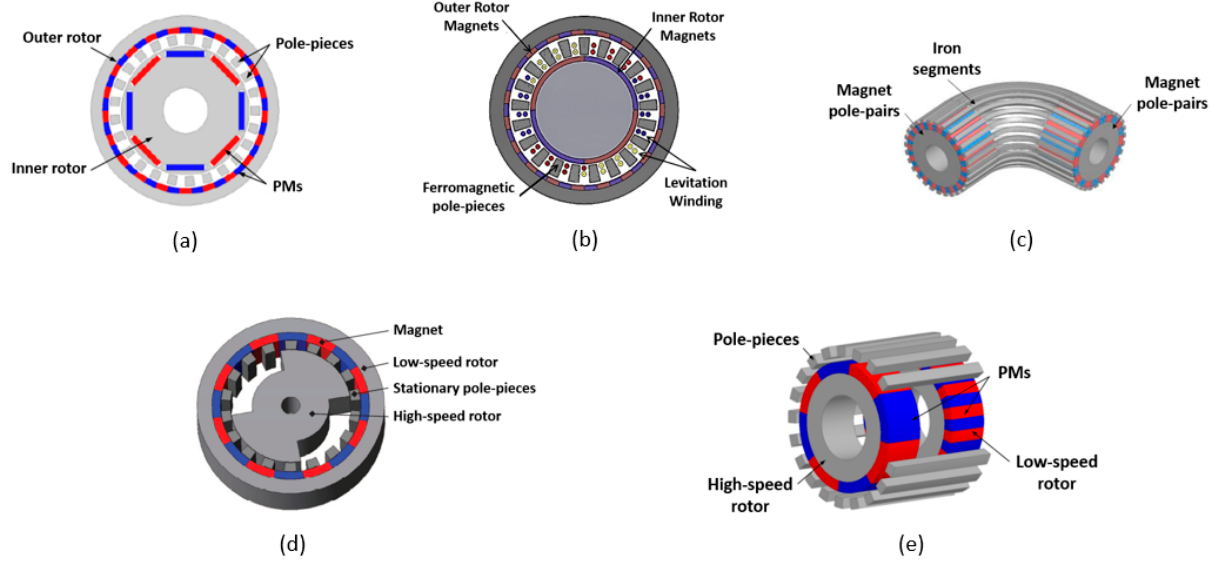
Figure 11. Variations of flux modulated coaxial magnetic gear topologies: ( a ) Surface-Mounted Coaxial MG with interior PM rotor; ( b ) Bearingless Coaxial MG: magnetic planetary gear with magnetic suspension; ( c ) Intersecting-axes MG; ( d ) Reluctance MG; ( e ) Transverse flux MG.